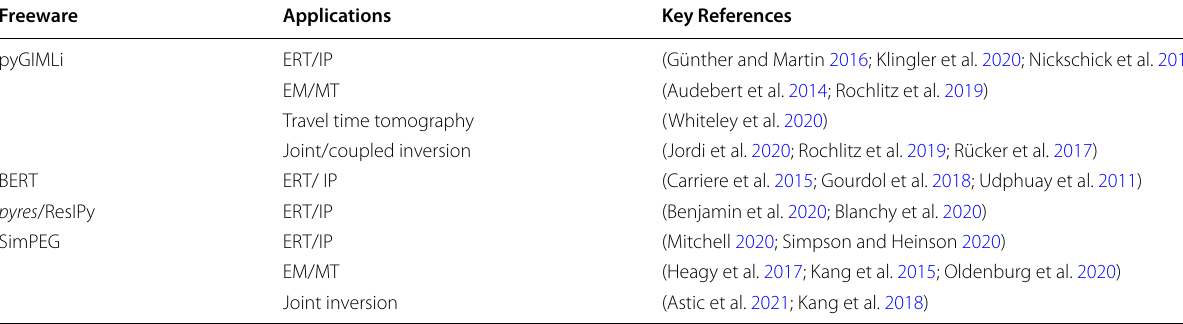
Table 2 Implementation of inversion freeware for reproducible geophysical